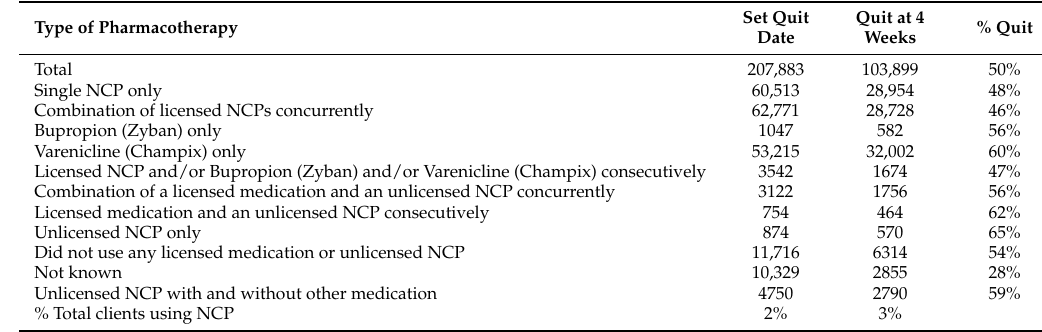
Table 1. English local Stop Smoking Services monitoring data April to September